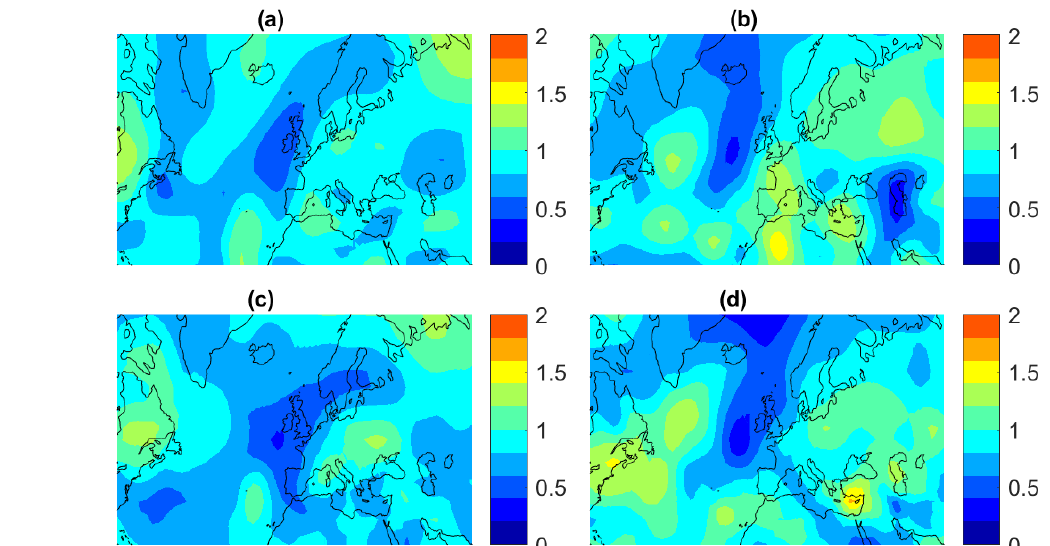
Figure 4. Cluster uncertainty. Standard deviation of 500hPa geopotential height [m] (a, b) and sea-level pressure [hPa] (e, f) of the two clusters of cold spells in Italy found via k